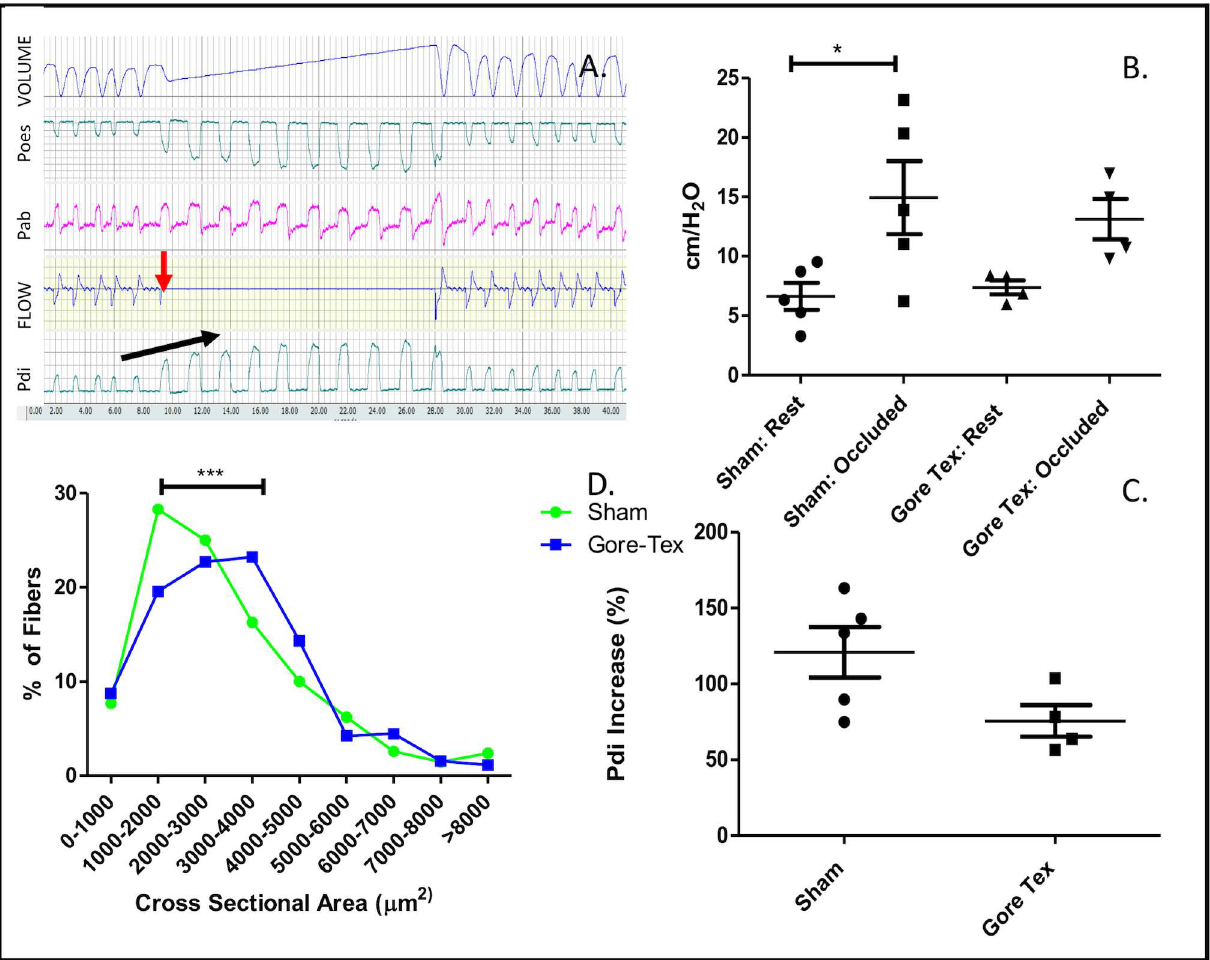
Fig 5. Diaphragmatic Outcomes. A. Transdiaphragmatic pressure measurement: airflow recordingshowingtracheostomyocclusionwith halt of airflow (red arrow), increasein Pdi (black arrow). B. Pdi increasesin Sham and Gore-Tex implantedanimalsfollowingtracheostomy occlusion,C. Increase in Pdi as a % change at rest and followingocclusion,D. Right hemi diaphragmatic muscle fiber cross sectional( μ m 2 ) area is increasedin Gore-Tex implantedanimals. Poes : oesophageal pressure , Pab : abdominal pressure , Pdi : transdiaphragmatic pressure .